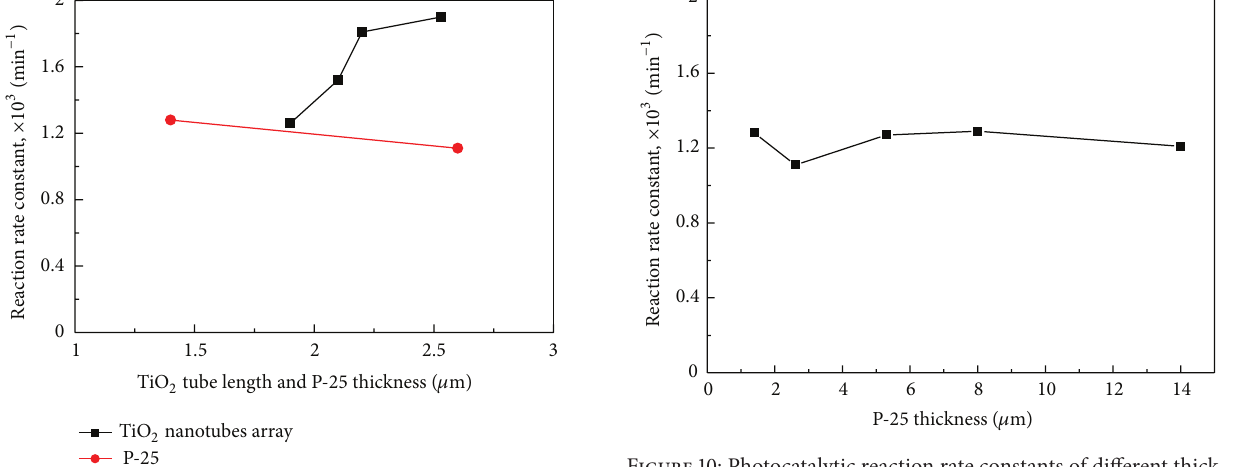
Figure 10: Photocatalytic reaction rate constants of different thick- nesses of P-25 film ranged from 1400 to